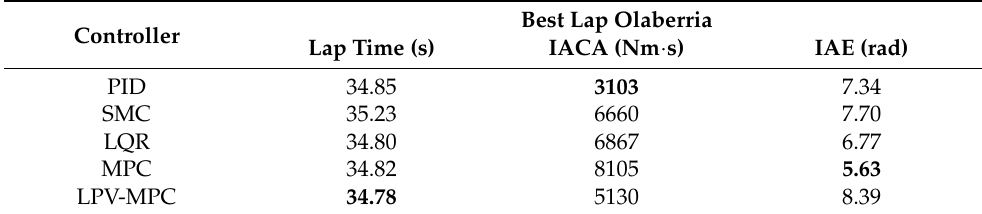
Table 8. Controller performance at